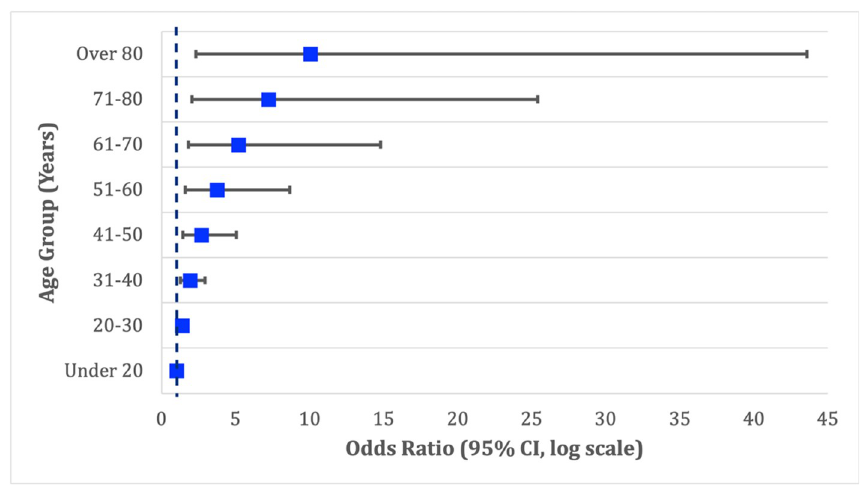
Fig 1. Forest plot of odds ratios for COVID-19 vaccination intention by age